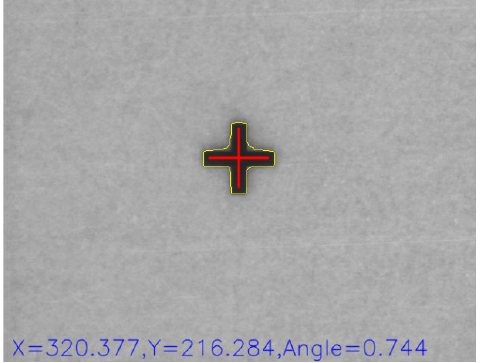
Figure 6. Cross ‐ mask position obtained using the center ‐ of ‐ gravity method [4].